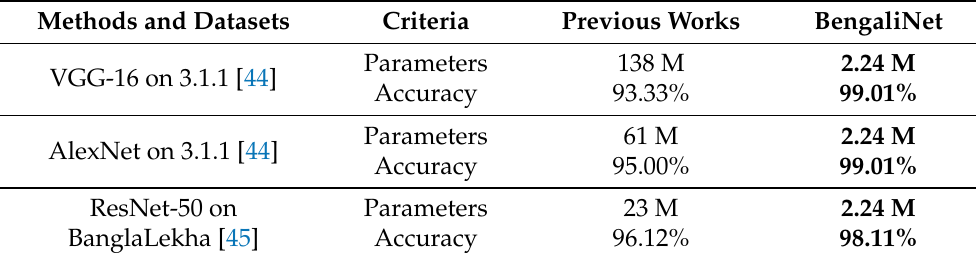
Table 9. Comparison with previous studies in terms of total parameters and overall